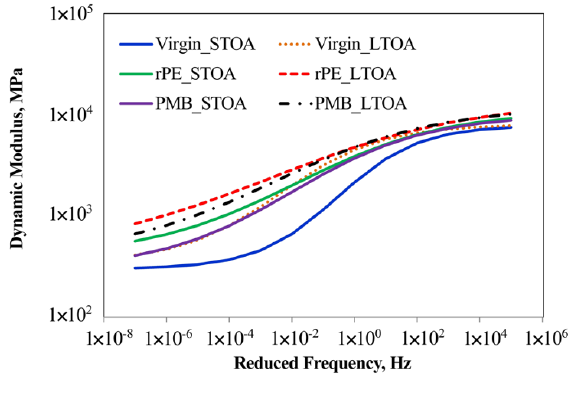
Fig. 8. Dynamic modulus master curves of